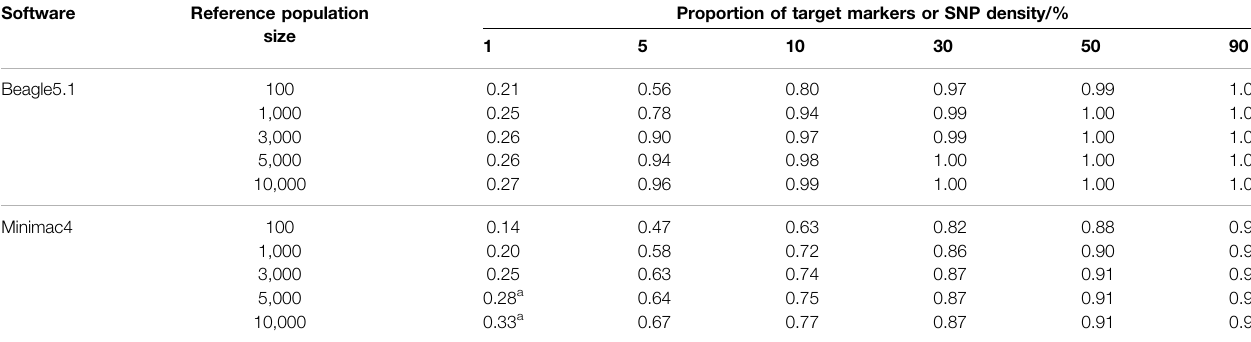
TABLE 5 | Imputation reliability for different levels of imputation reference population size and SNP density. Software Reference population